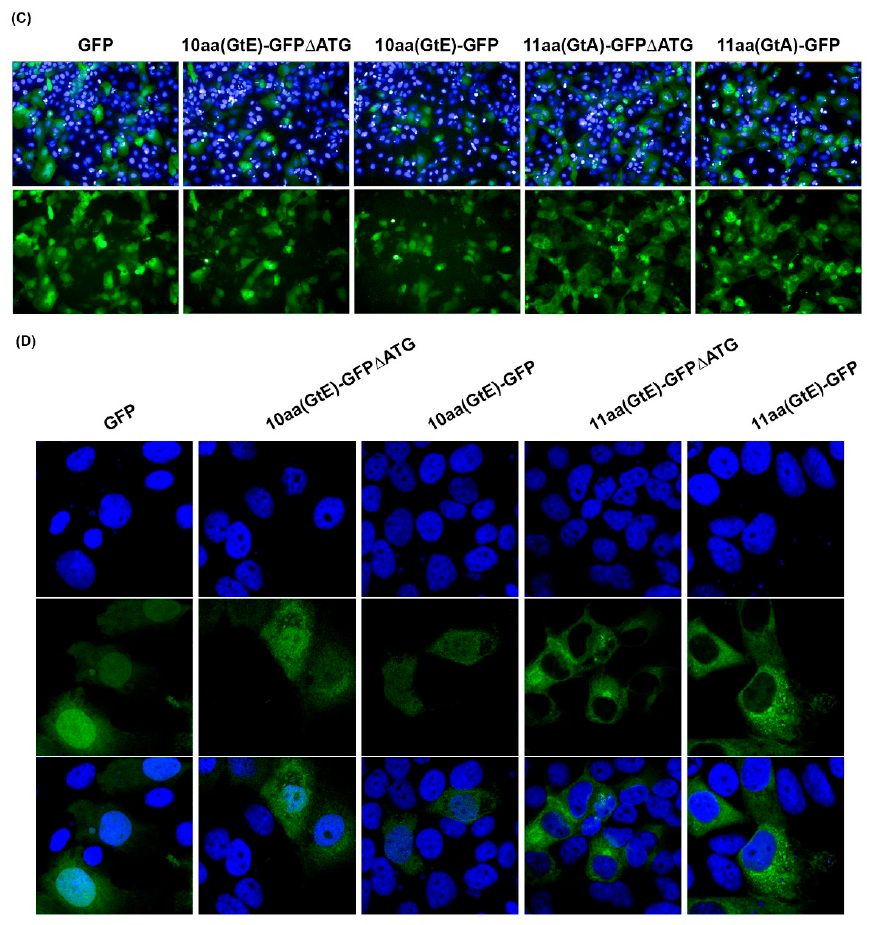
Figure 9. The impact of the N-terminal 11aa and 10aa on amount and distribution is independent from the LHBs context. ( A ) Schematic illustration of the start sites of eGFP and its fusion protein containing either 11 aa or 10 aa derived from N-terminal PreS1 of GtA or GtE. ( B ) eGFP level in Huh7.5 cells overexpressing genomes eGFP and its derivatives were analyzed by Western blot using an anti-eGFP specific serum and by microplate reader from Tecan by exciting the protein at 490 nm. As control, actin was used in Western blot, and in the microplate reader assay, nuclei were stained with DAPI and excited at 358 nm. ( C ) Huh7.5 cells overexpressing genomes eGFP and its derivatives were analyzed by Operetta high-content imaging system from PerkinElmer. Nuclei were stained with DAPI in blue. The signal from eGFP was standardized as 1. Ls, lysate; sp, supernatant. These quantitative data are mean values from three independent experiments. ( D ) CLSM analysis of Huh7.5 cells expressing these mutants. *, p < 0.05; **, p <